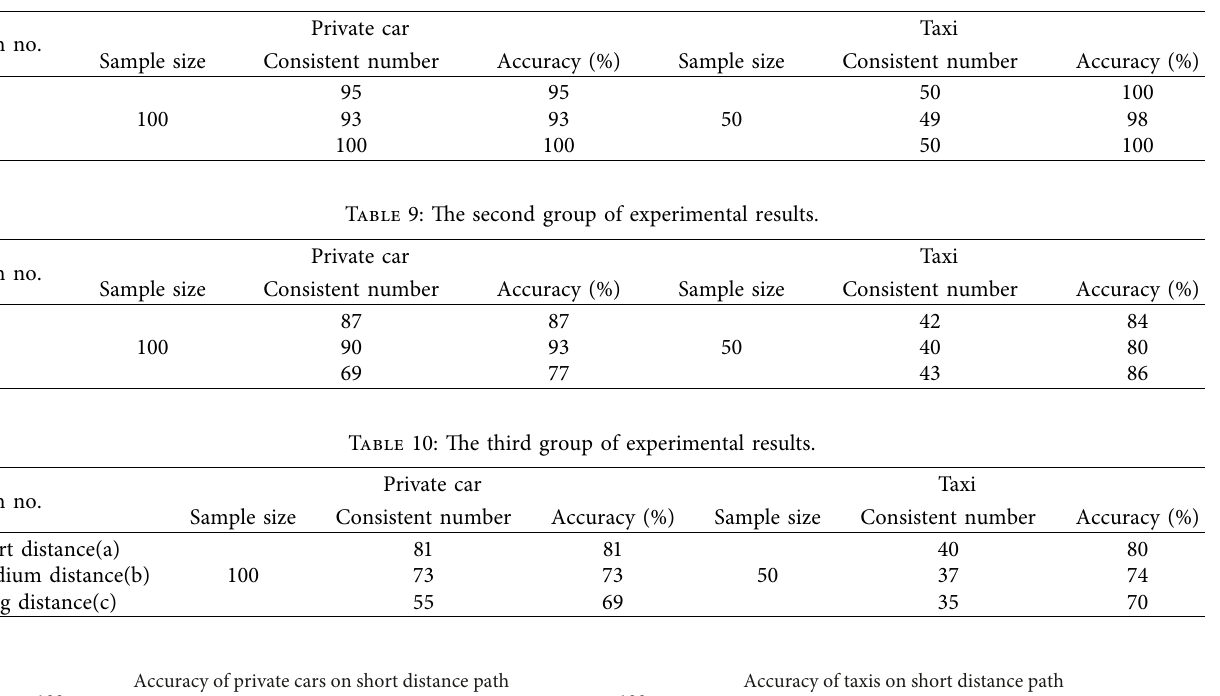
Table 8: The first group of experimental results.